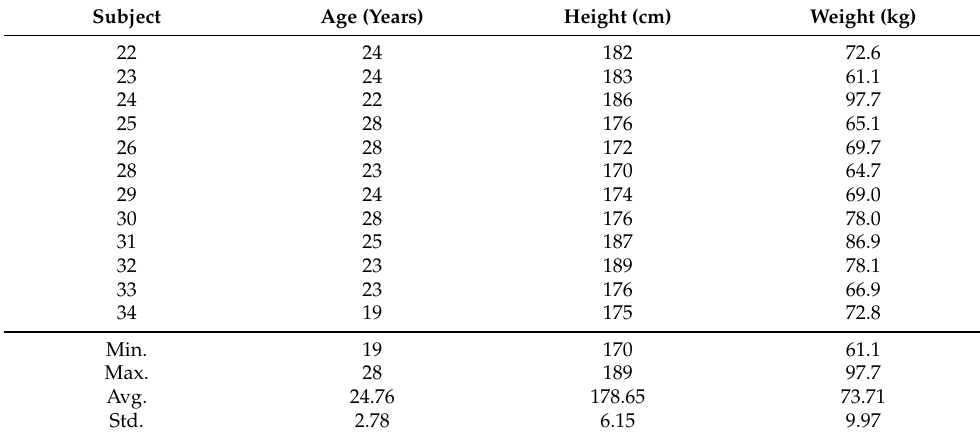
Table 2. Subjects’